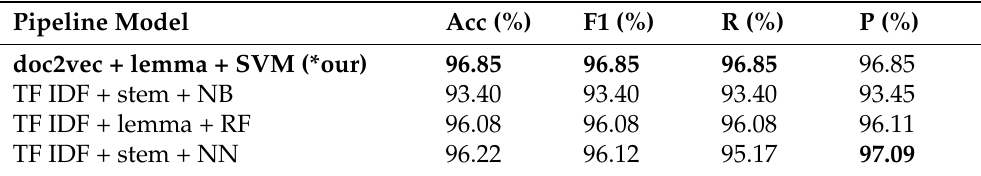
Table 8. Comparison of the best results of the classification